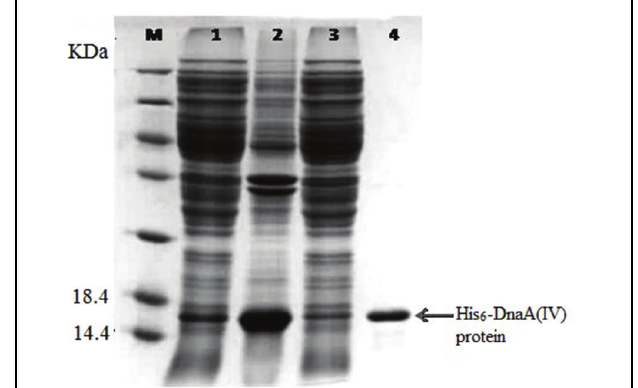
FIGURE 3 | Expression of the His 6 -DnaA (IV) in Escherichia coli cells. Sodium dodecyl sulfate-polyacrylamide gel electrophoresis (SDS-PAGE) analysis of the total Cyanothece 51142 cell proteins. Molecular mass markers (M) are indicated on the left and the positions of the protein are indicated on the right. Lane 1, supernatant of cell lysate; Lane 2, precipitant of cell lysate; Lane 3, breakthrough peak in the affinity chromatogram; Lane 4, targeted protein in the affinity